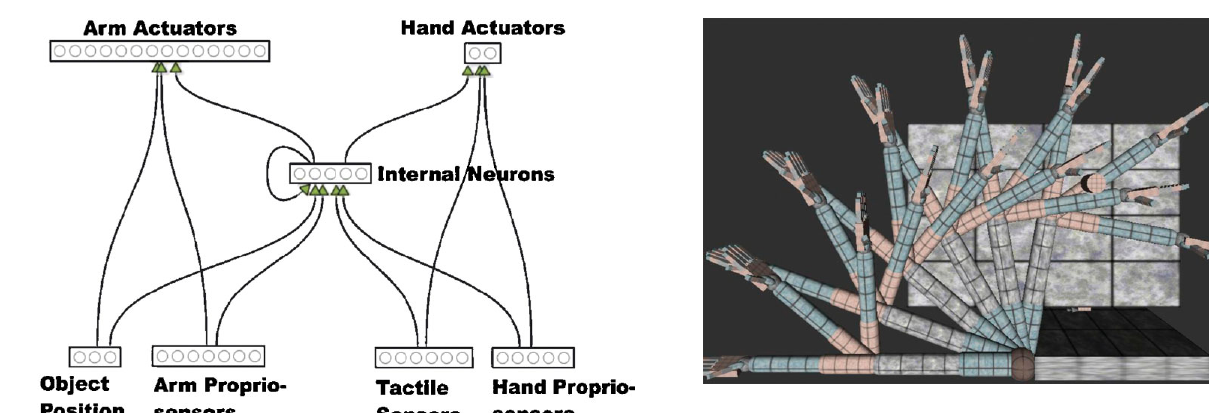
[0, + 1] (for alternative ways to implement leaky neurons see, for example, Beer,